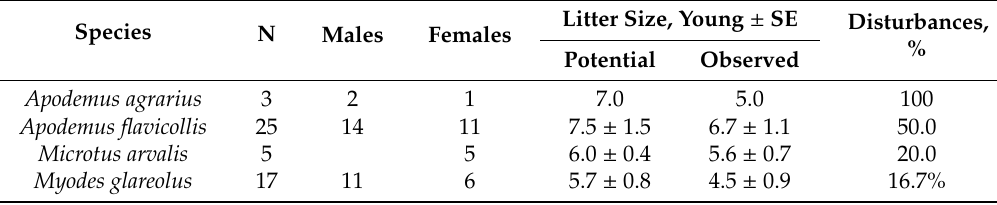
Table 4. Breeding data of the most abundant small mammals from the commensal